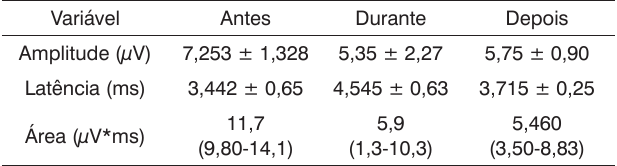
Tabela 2. Dados gerais da população de estudo.